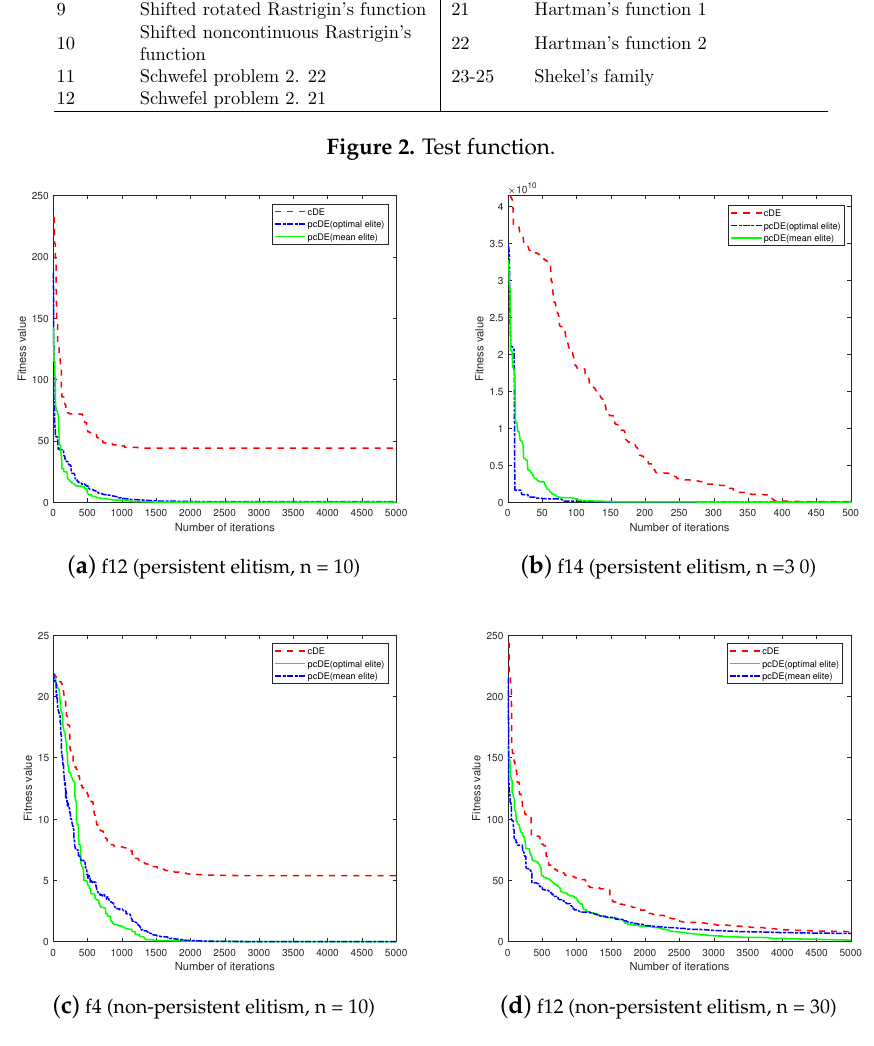
Figure 3. Performance trends pcDE vs.